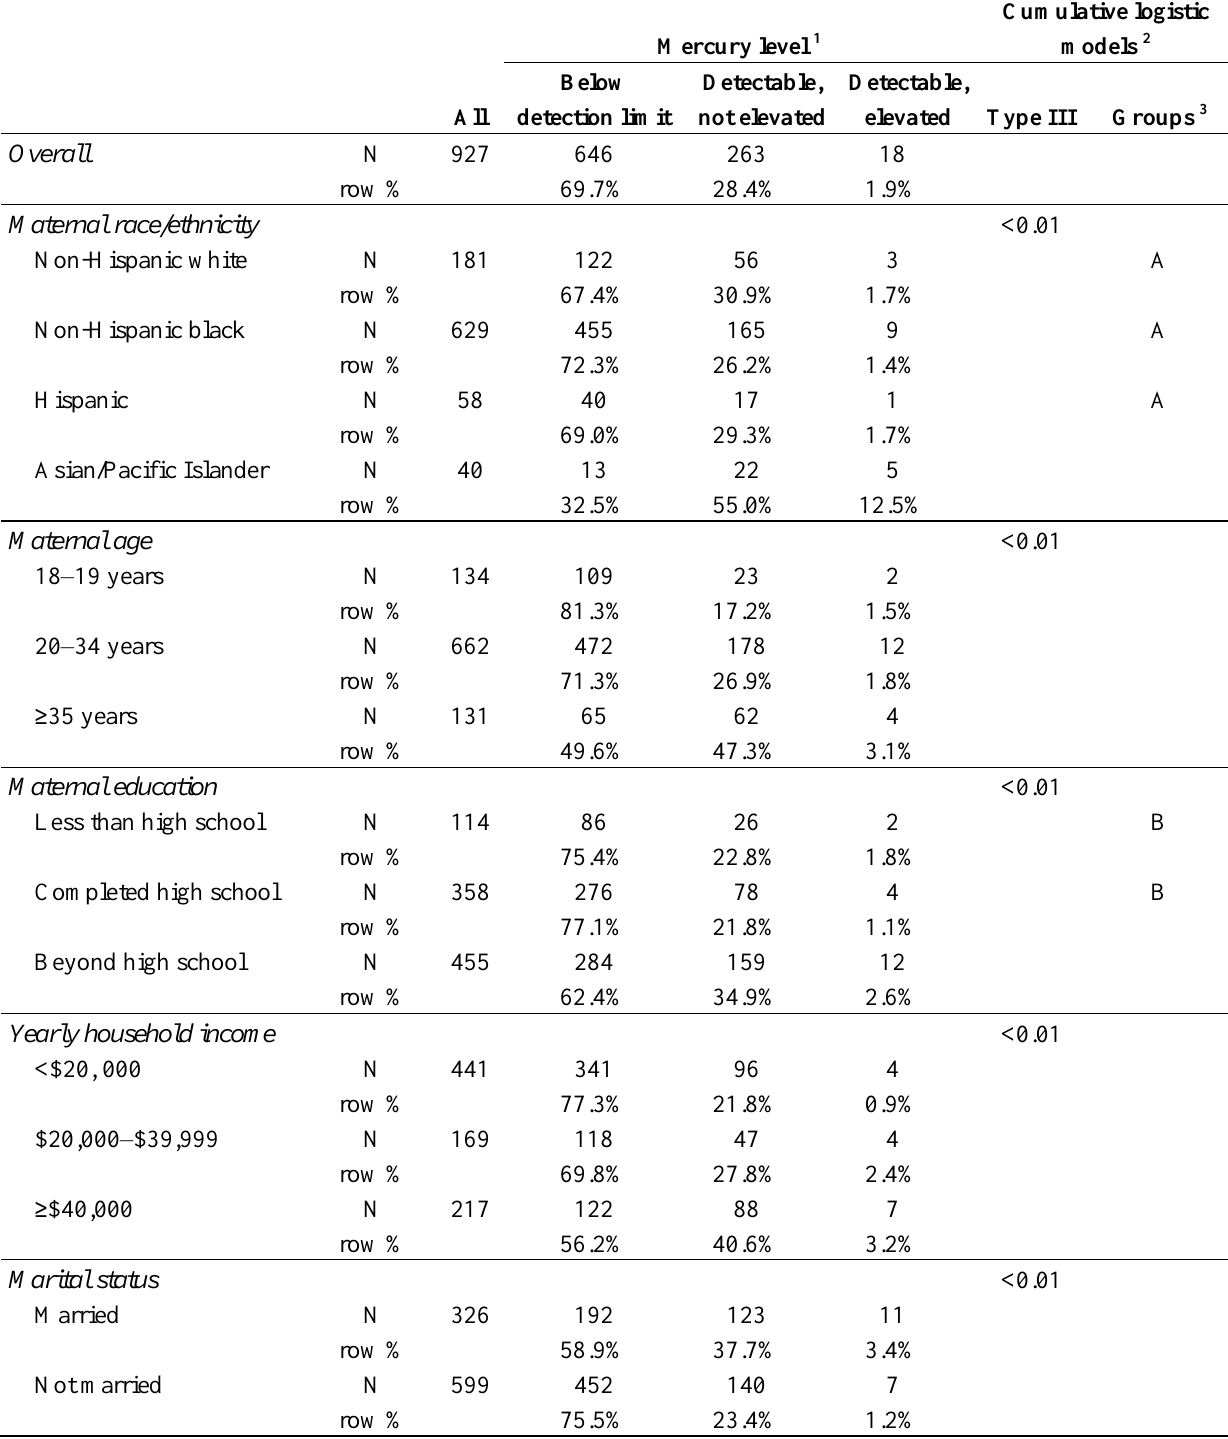
Table 1. Distribution of blood mercury levels by demographic and socioeconomic characteristics and results from simple cumulative logistic models for mercury